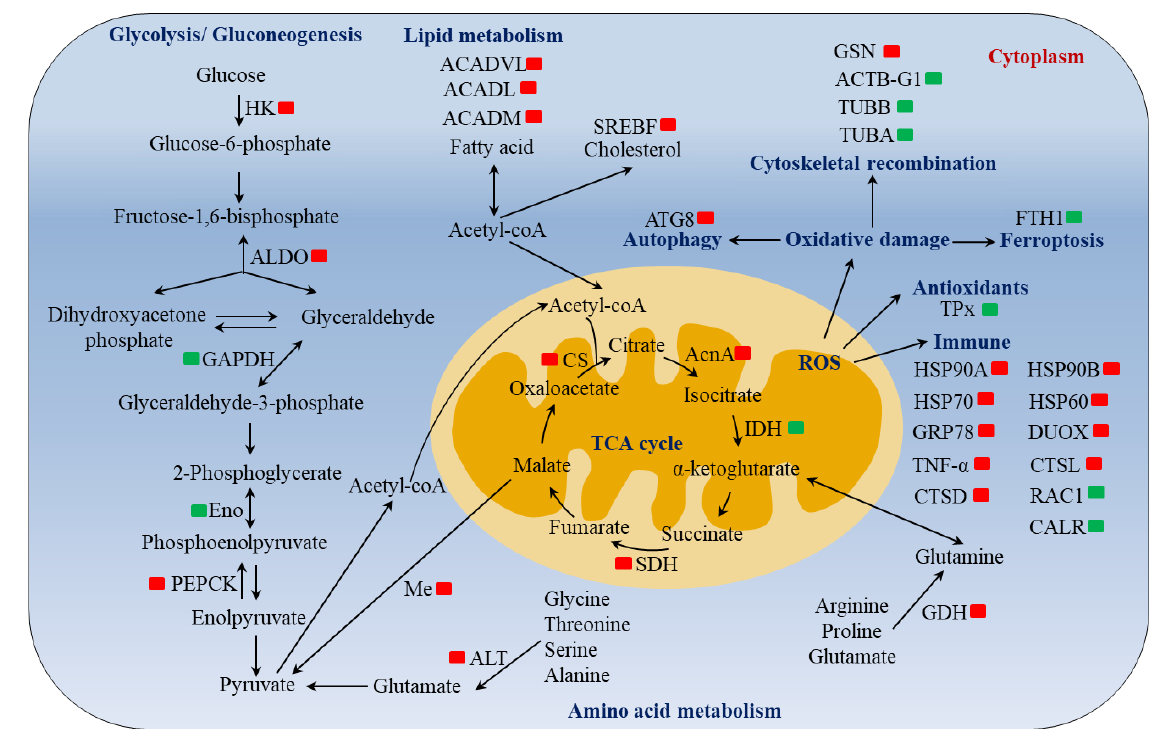
Figure 6. Schematic overview of air exposure-induced alterations of gene expression in metabolism, immune, cytoskeleton reconstruction, autophagy, and ferroptosis in the gill of C. fluminea . Red and green present upregulation and downregulation of genes, respectively.